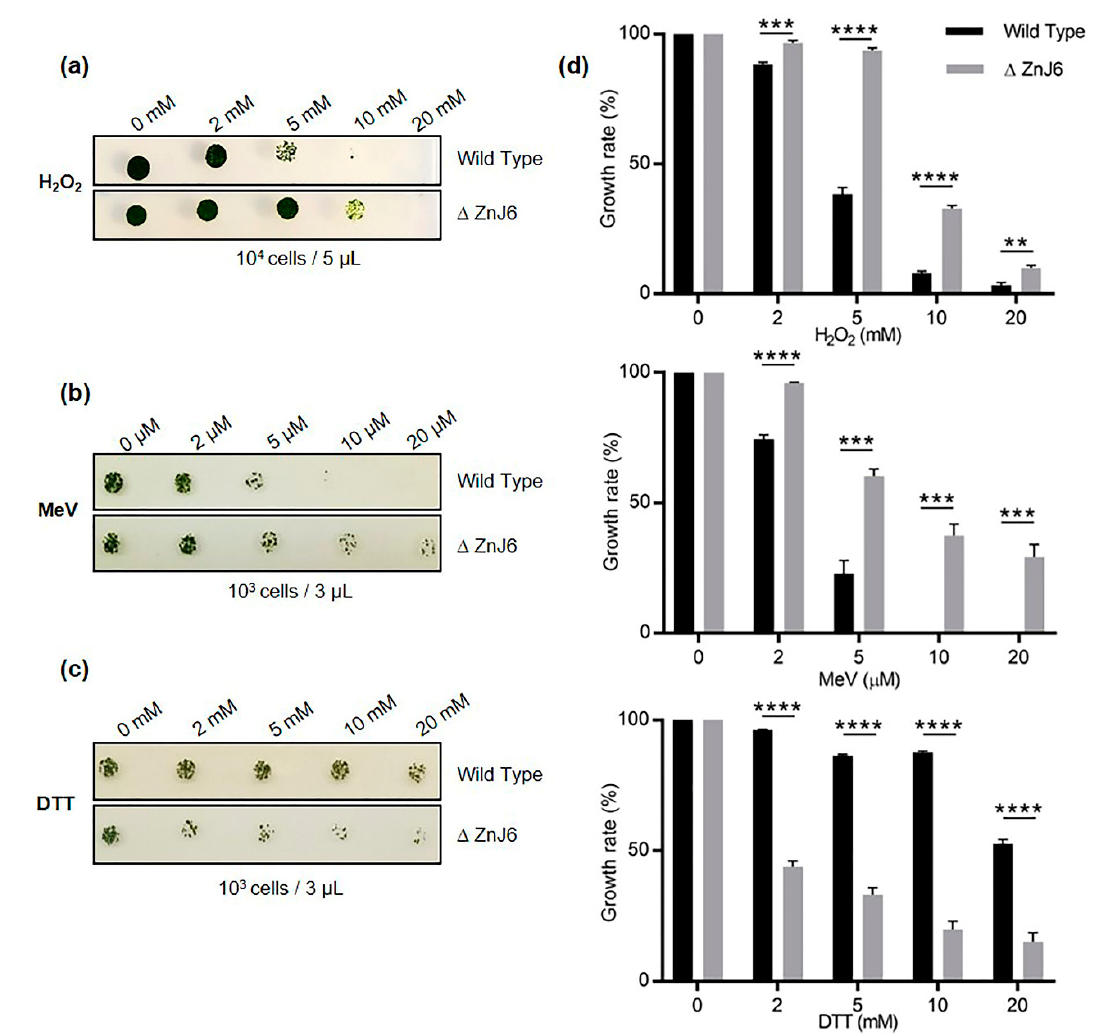
Figure 8. ZnJ6 knock-down mutant of C. reinhardtii ( ∆ ZnJ6) shows tolerance to oxidative stress but increased sensitivity to reducing conditions. ( a ), ( b ) WT and ∆ ZnJ6 cells were exposed to oxidizing conditions by incubation with increasing concentrations of hydrogen peroxide (H 2 O 2 ) and methyl viologen (MeV) for 1 h respectively. The cells were washed, and growth was monitored on high salt (HS) plates. ( c ) Cells were exposed to reducing conditions by incubation with DTT for 2 h. The cells were washed, and growth was monitored by plating over HS plates. ( d ) Growth variations of cells treated with H 2 O 2 , MeV, or DTT, as shown in panels A–C, were measured using the MultiGauge software. The growth of untreated cells served as control (100%). The figure is representative of one of the three repeats. t -test was used for analysis, and the error bars are standard deviations. (****, ***, **: p values ≤ 0.0001, 0.001 and 0.01, respectively).